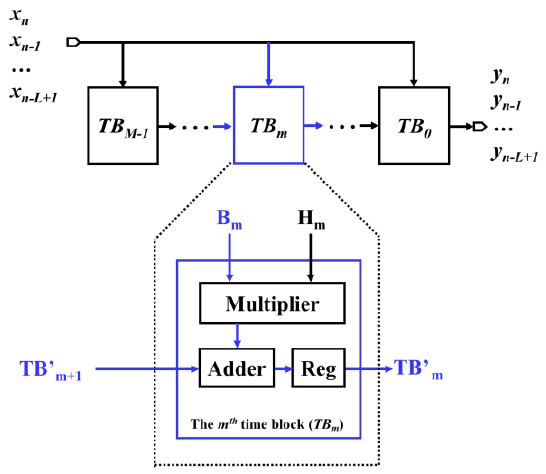
Figure 2. Time-block-based transposed block FIR architecture.